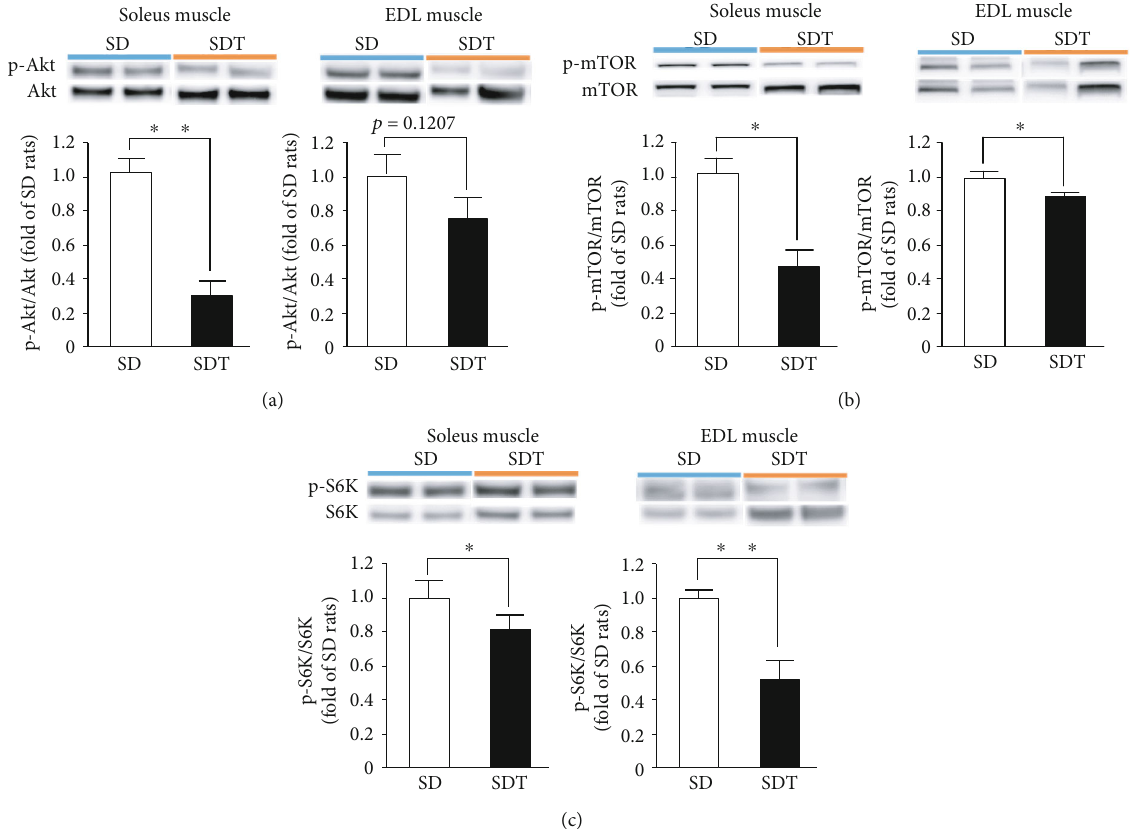
Figure 4: Muscle protein synthesis in SD and SDT fatty rats, as determined by western blot analysis. Phosphorylated Akt (a), mTOR (b), and S6K (c) in the soleus and EDL muscles. ∗ p < 0 : 05 and ∗∗ p < 0 : 01 vs. SD rats.